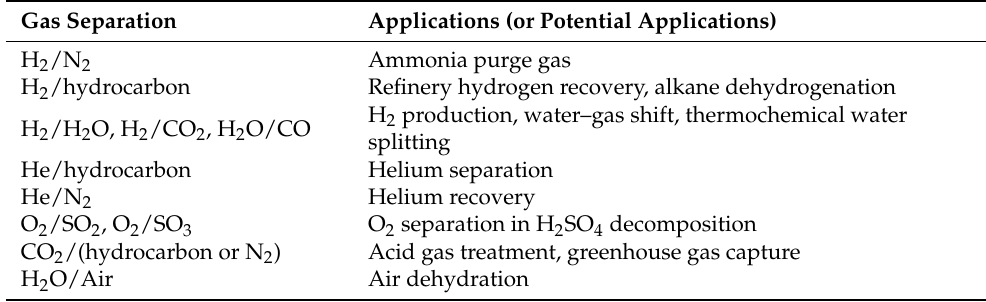
Table 4. Various (potential) applications of SiC membrane for gas